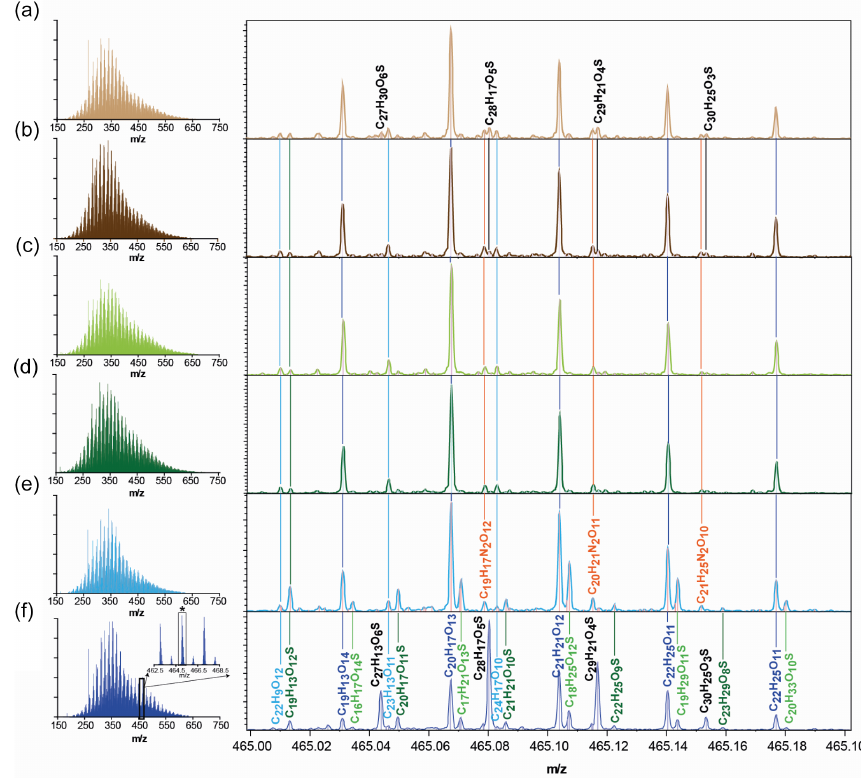
Figure 6. Left panel: negative electrospray 12T FTICR mass spectra of Wetlands SPE-DOM (inset in Fig. 6f shows an enlarged mass view of a mass range of 6.0Da. Right panel: expansion of the mass segment m/z = 465.00–465.20 ( (cid:49)m = 0.2Da; asterisk in inset Fig. 6f), with assignment according to CHO, CHNO, CHOS and CHNOS molecular series. (a) OKA-L; (b) OKA-S; (c) PAN-L; (d) PAN-S; (e) FCE-L; (f)